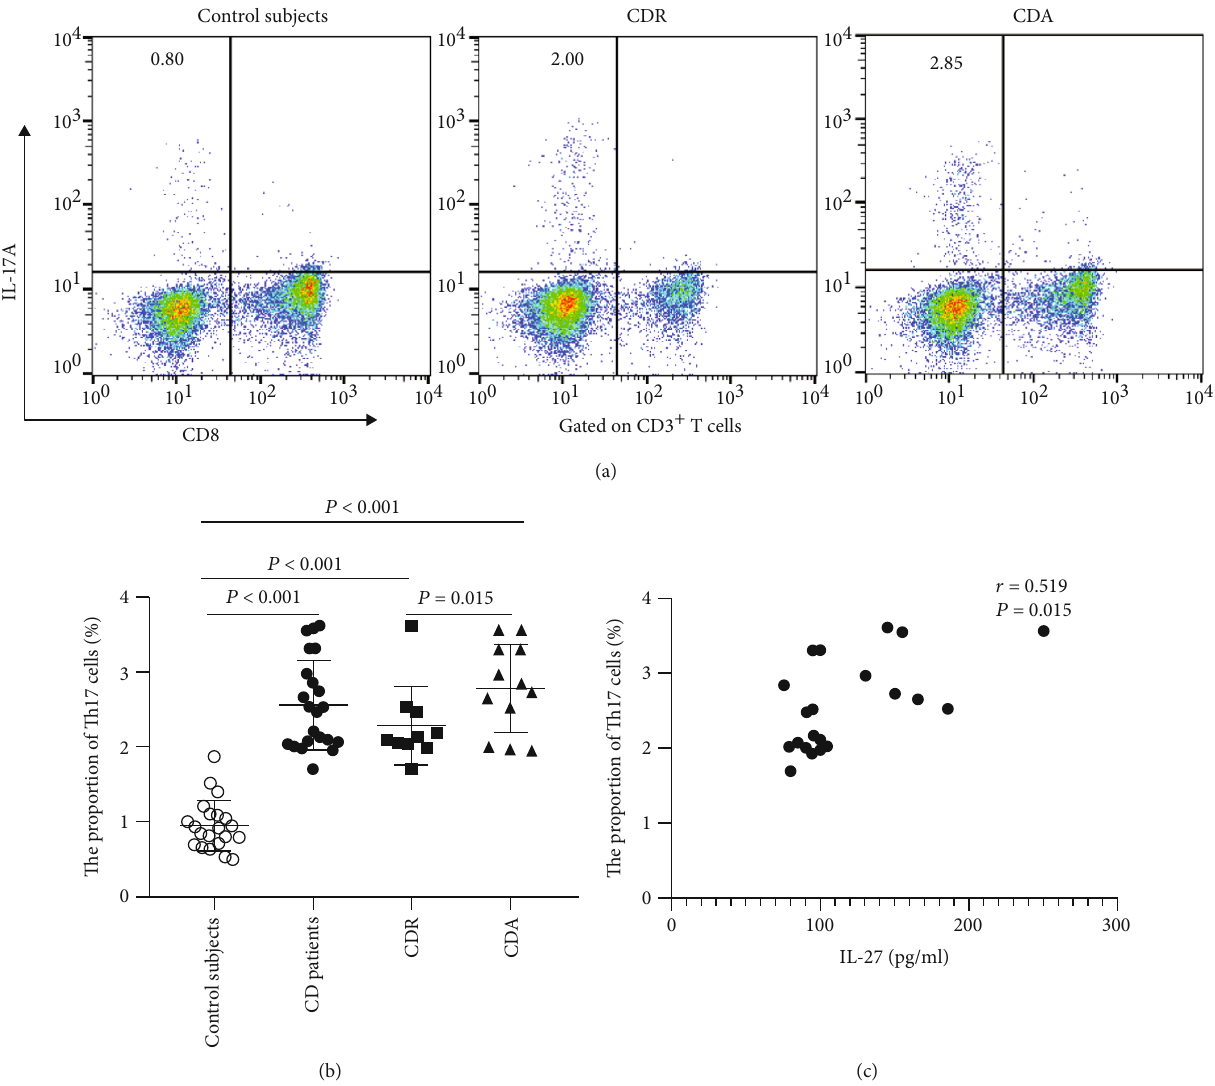
Figure 5: Circulating Th17 cells in healthy control subjects, all CD patients, CDR patients, and CDA patients and their relationship with serum IL-27 levels. (a) Representative dot plots of IL-17A expression in peripheral CD4 + T cells (gate CD3 + CD8 - T cells) of HC subjects, all CD patients, CDR, and CDA. (b) Scatter plot showing the proportion of circulating Th17 cells and the results of statistical analysis by using the nonparametric Mann – Whitney rank test. (c) Correlation of serum IL-27 levels with circulating Th17 cells. Spearman ’ s rank correlation test was used to assess the correlations. CD: Crohn ’ s disease; CDR: CD patients in remission; CDA: CD patients in